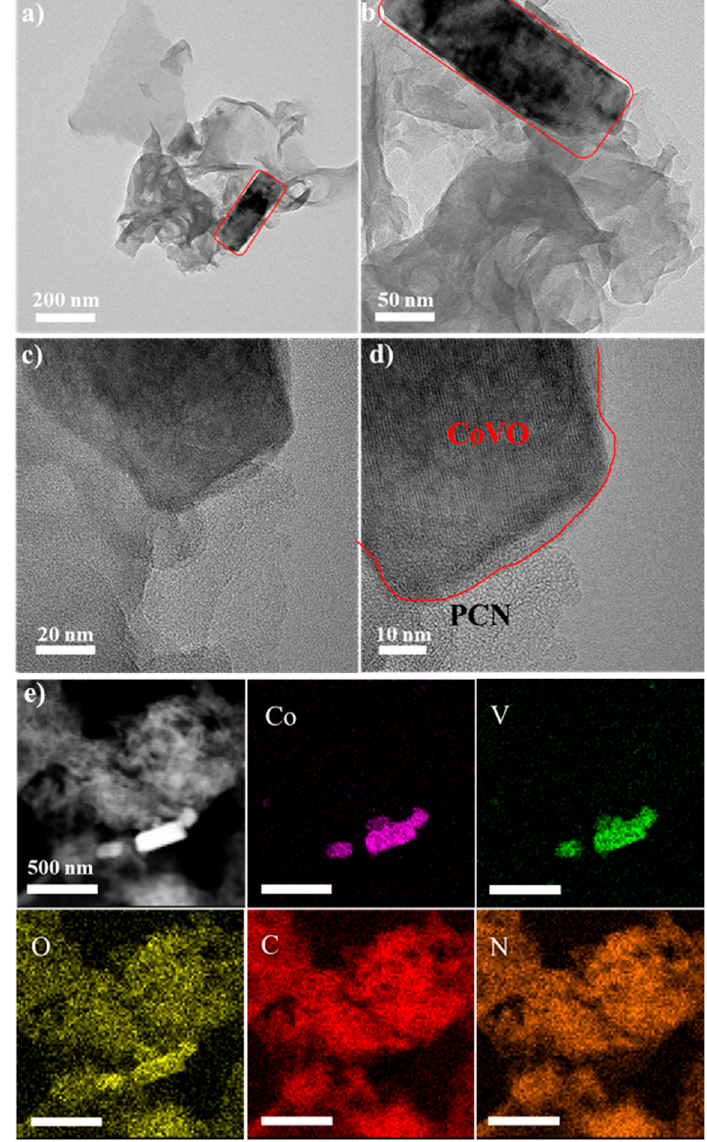
Figure 2 . ( a – d ) TEM images; ( e ) HRTEM mapping of 3 wt % CoVO/PCN